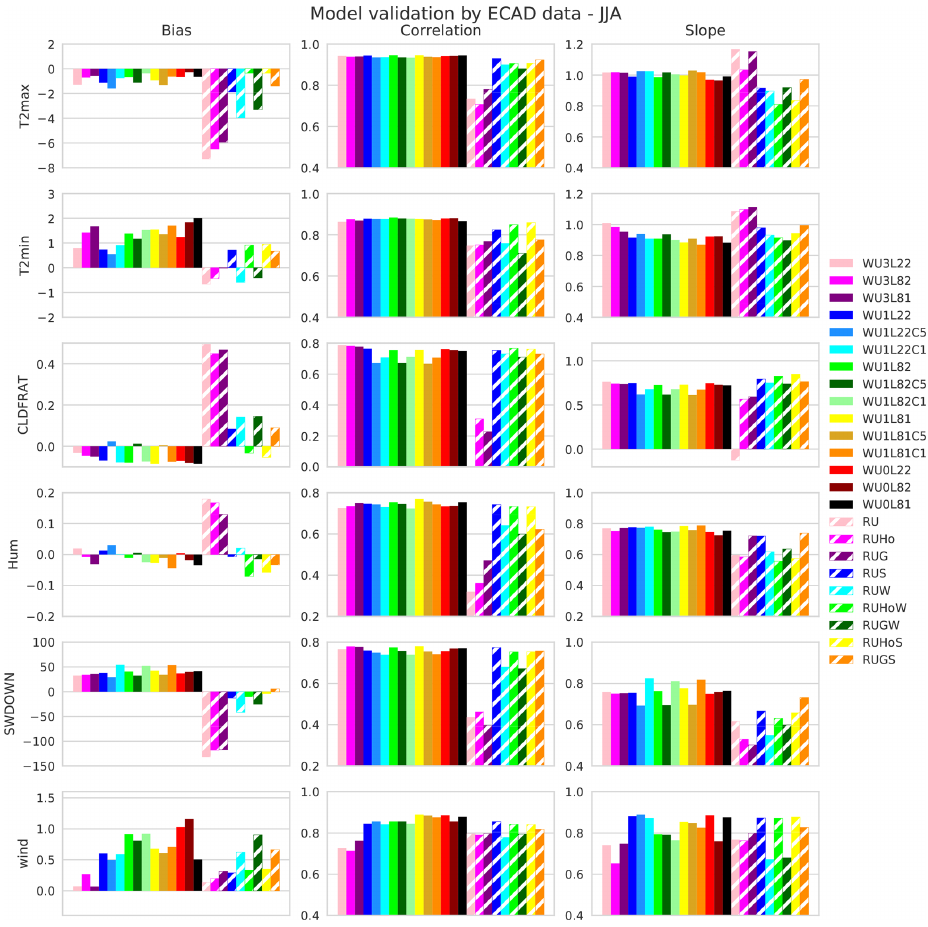
Figure 5. Same as in Fig. 4 but for the summer season.